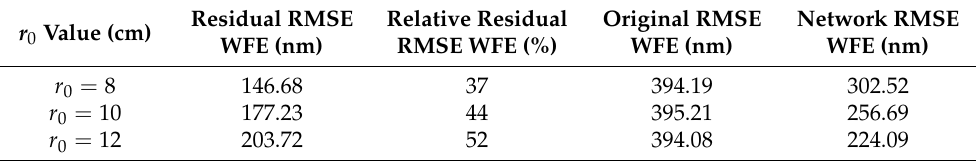
Table 7. Results obtained for the FCN model, when reconstructing the approximated profile of the phase. Each value is obtained as the mean value over the 3000 samples of the test dataset.